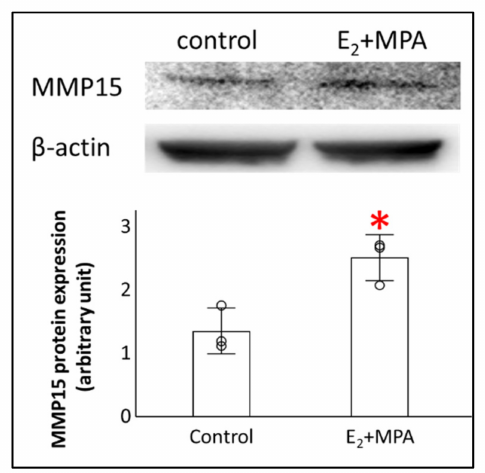
Figure 2. Effect of E 2 + MPA treatment on MMP15 proteins in human endometrial stromal cells. Human endometrial stromal cells were treated with E 2 (10 − 8 mol/L) + MPA (10 − 7 mol/L) (E 2 + MPA) or without hormonal treatment (control) for 12 days. The protein expression levels of MMP15 and β -actin were analyzed by immunoblot analysis. MMP15 were normalized to those of β -actin. Values are shown as mean fold change ± SD of independent experiments using cells derived from different patients ( n = 3). Each dot indicates the value for different cell preparations. An asterisk indicates statistically significant differences from the control group, * p <